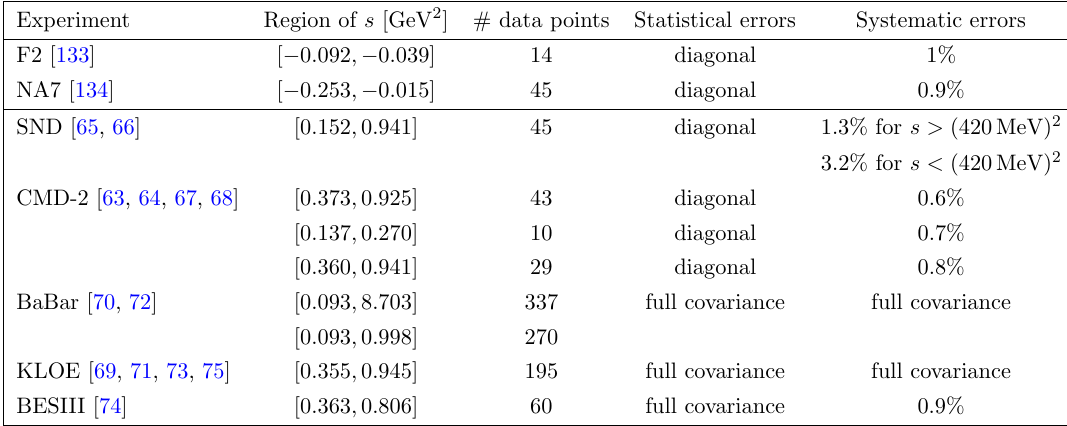
Table 1. Overview of the data sets that we use for the (cid:12)ts of the pion VFF. In most cases, the systematic uncertainty is an overall normalization uncertainty with 100% correlation between all data points. For CMD-2, we treat the systematics between [63, 64, 67], and [68] as fully correlated, apart from the event separation, which is uncorrelated between the low-energy [67] and high- energy [63, 64, 68] data sets [139]. For BaBar and KLOE, the systematic uncertainties have a more complicated covariance structure. From the BaBar data set, we only use the 270 data points below 1 GeV 2